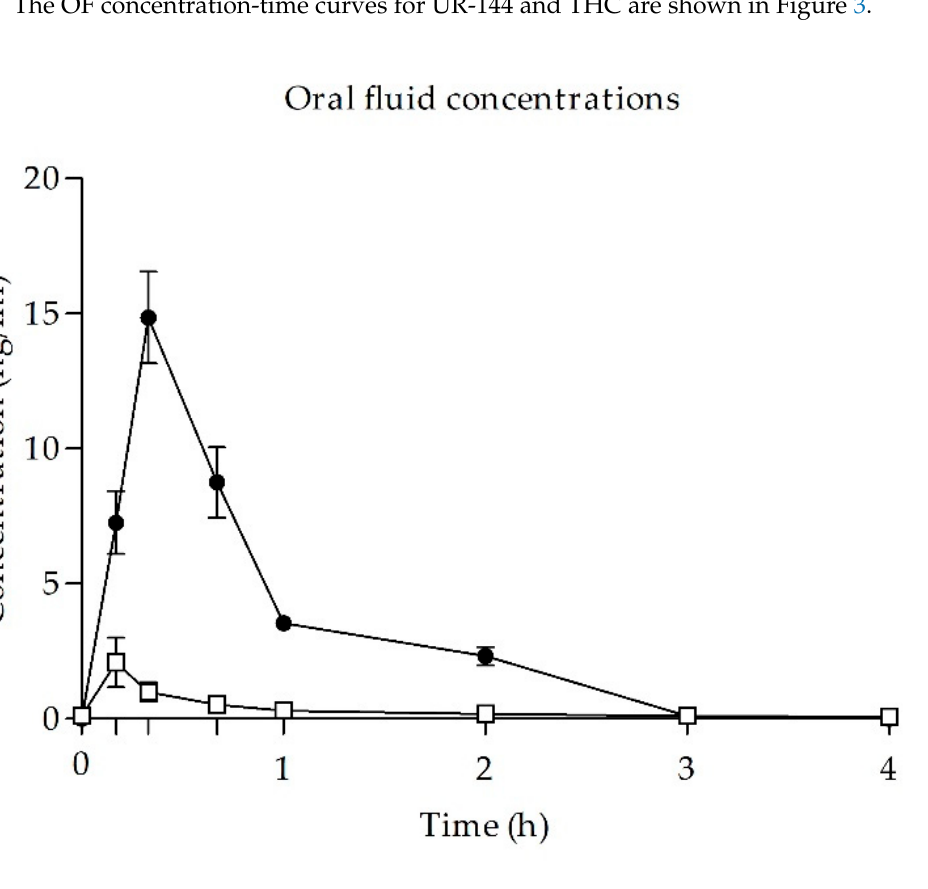
Figure 3. Time course of UR-144 (n = 8) and cannabis (n = 8) concentrations in oral fluid. Symbols: ● UR-144; □ THC; values are mean and standard